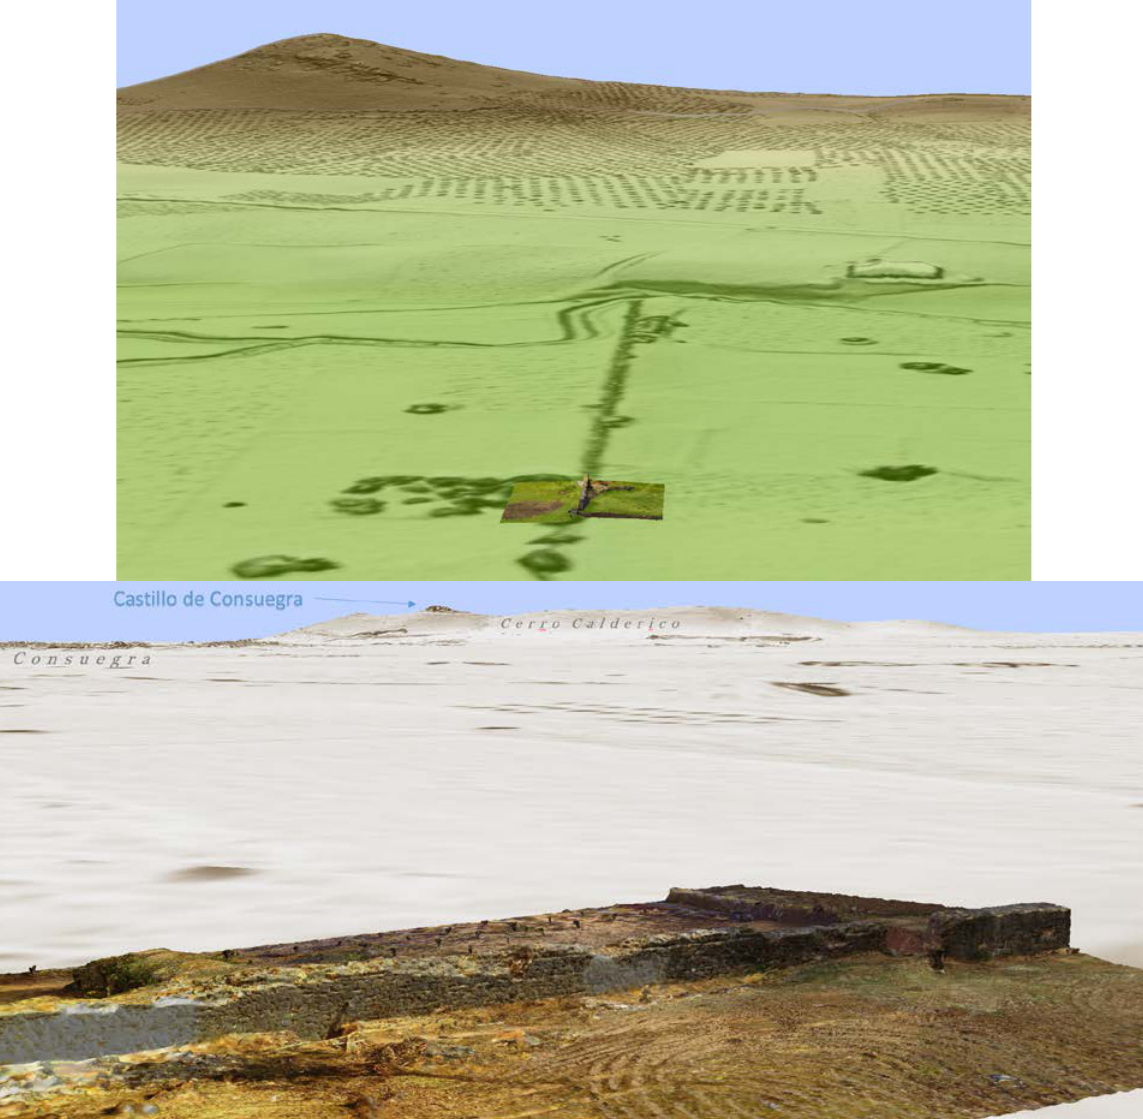
Figure 8. DSM made from aerial LiDAR data that is merged with 3D model of Roman dam made using collected TLS data (top); hillshade model made from aerial LiDAR data and same 3D model